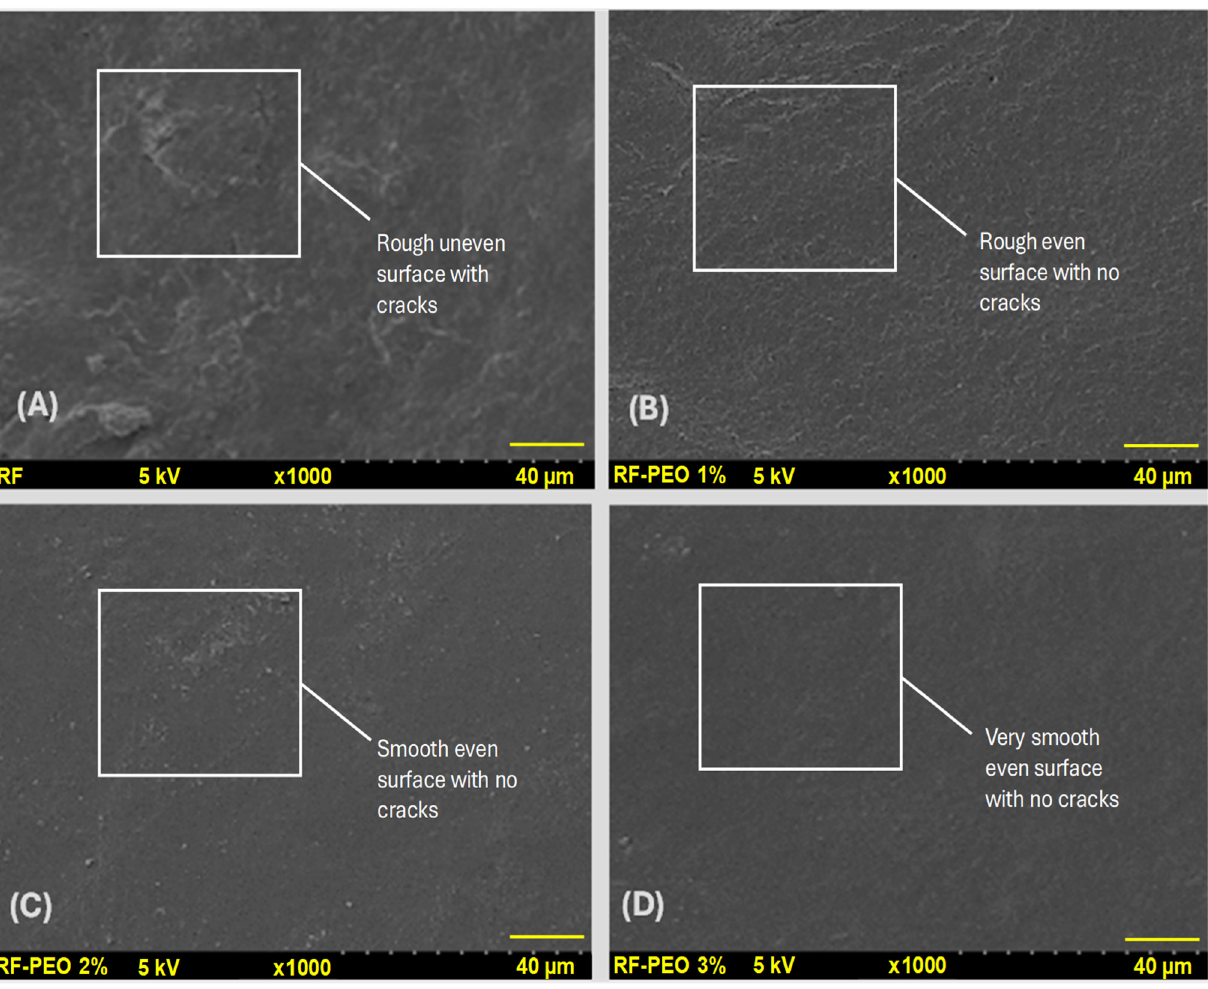
Figure 7. Microstructural observation control fi lm ( A ), RF–PEO 1% ( B ), RF–PEO 2% ( C ), and RF– PEO 3% ( D ) of the edible fi lms composed of RF–PEO at varying